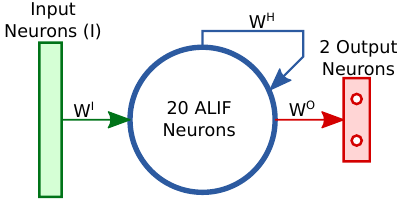
Figure 5. SNN architecture.